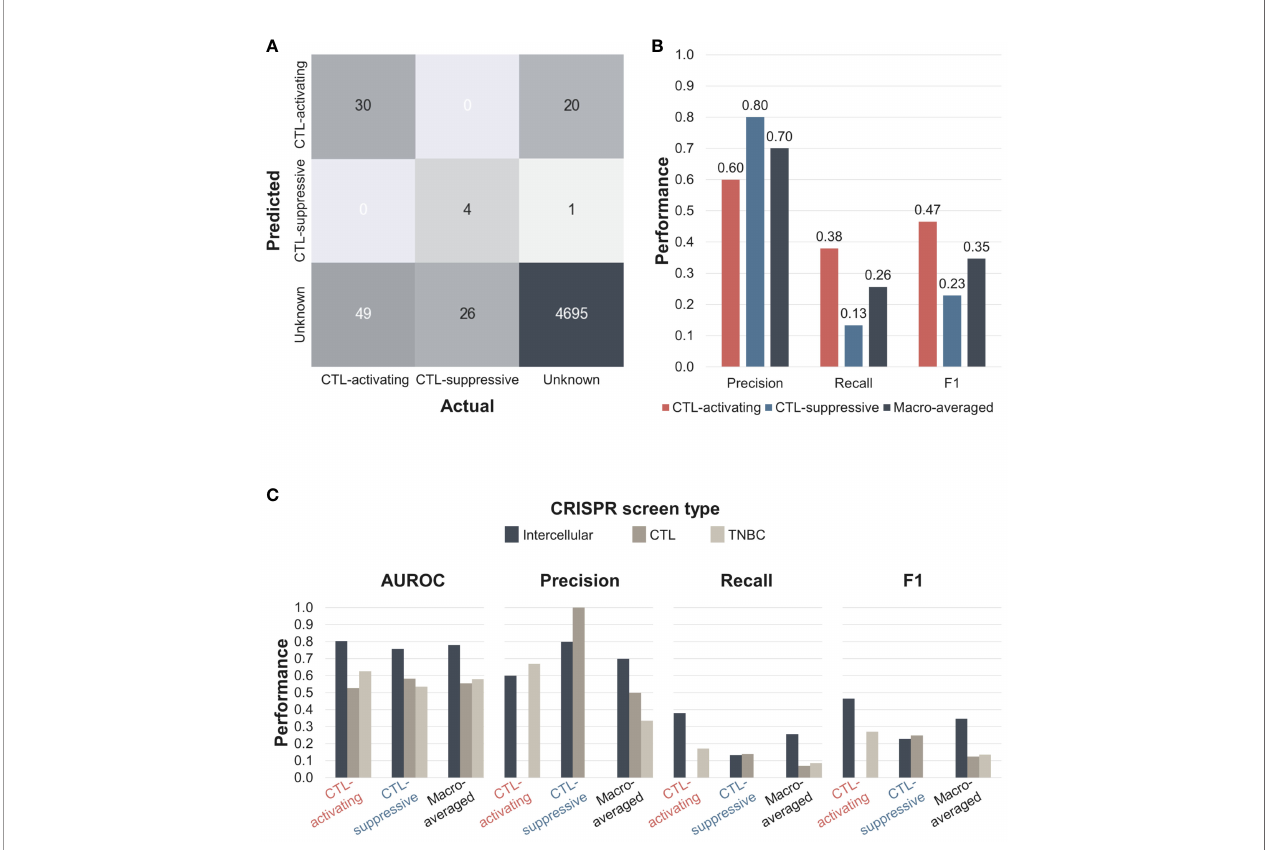
FIGURE 4 | The performance of the intercellular CRISPR screen ( ‘ Tolerant ’ method). (A) Confusion matrix of intercellular CRISPR screens. Predictions were made based on an FDR < 5%. (B) Precision, recall, and F1 scores of intercellular CRISPR screens. (C) AUROC, precision, recall, and F1 scores of CTL, TNBC, and intercellular CRISPR screens. AUROC, area under the receiver operating characteristic